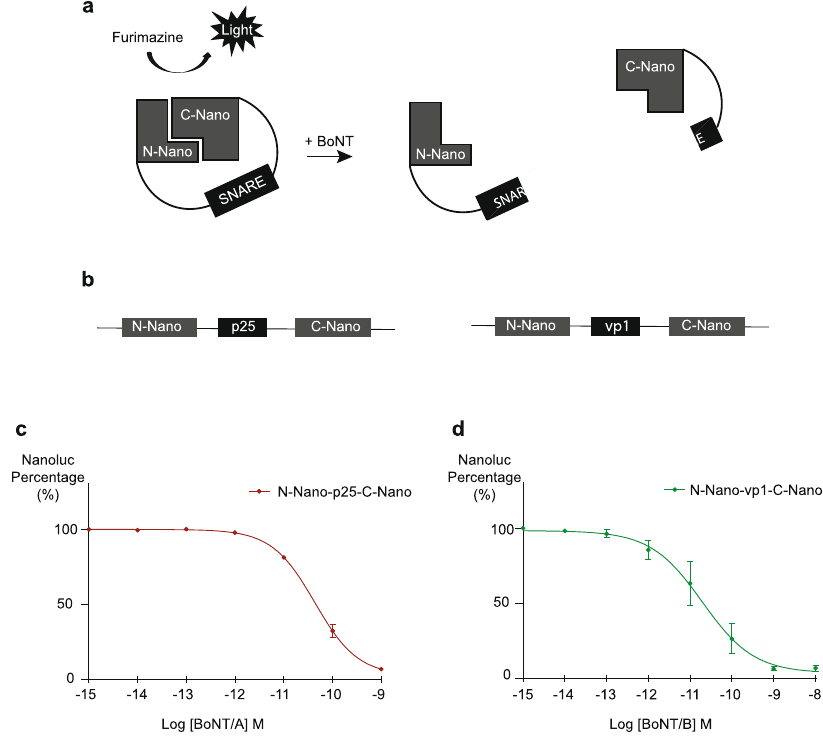
Fig. 1 Split luciferase sensors for detecting BoNT activity. a Schematic representation of the split luciferase-based biosensor. The split NanoLuc ™ luciferase is linked together by a linker containing a SNARE sequence. By cleaving the SNARE part of the sensor, BoNTs separate NanoLuc ™ luciferase and prevent it from reconstitution into a functional luciferase. The decrease in luminescence is inversely proportional to the toxin activity. b Schematic drawing of two sensor proteins designed for BoNTs detection. For SNAP-25 (p25)-cleaving BoNT, the sensor N-Nano-p25-C-Nano was prepared. For VAMP1(vp1)- cleaving BoNT, the sensor protein N-Nano-vp1-C-Nano was prepared. c Acellular detection assay of BoNT/A. Sensor proteins (30 nM) were mixed with different concentrations of BoNT/A. The curve was plotted based on the percentage of luminescence of NanoLuc luciferase by using toxin added sample/ control sample. Assay was performed in duplicate. d Acellular detection assay of BoNT/B. The process was the same as described for detecting BoNT/A. Assay was performed in